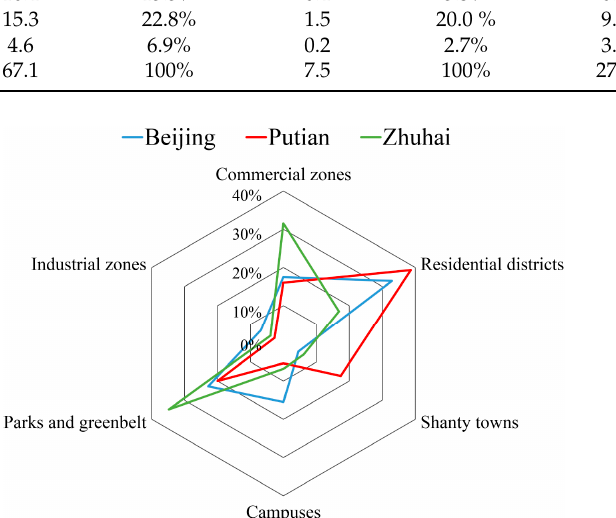
Figure 21. The proportions of diverse functional zones in the three study areas.